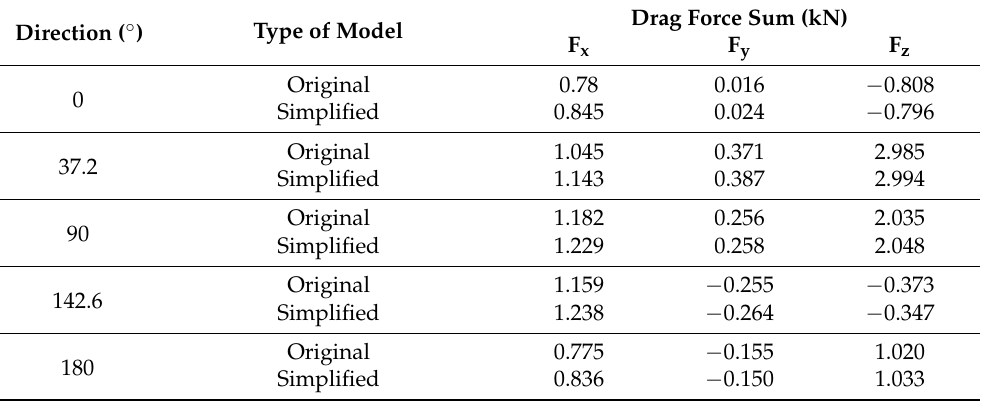
Table 1. Drag force for all directions of wind flow. Direction ( ◦